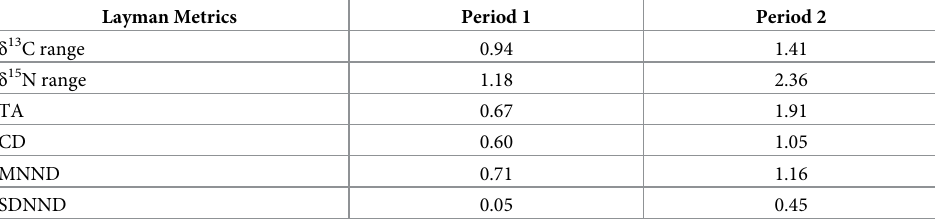
Table 5. Layman metrics estimated according to